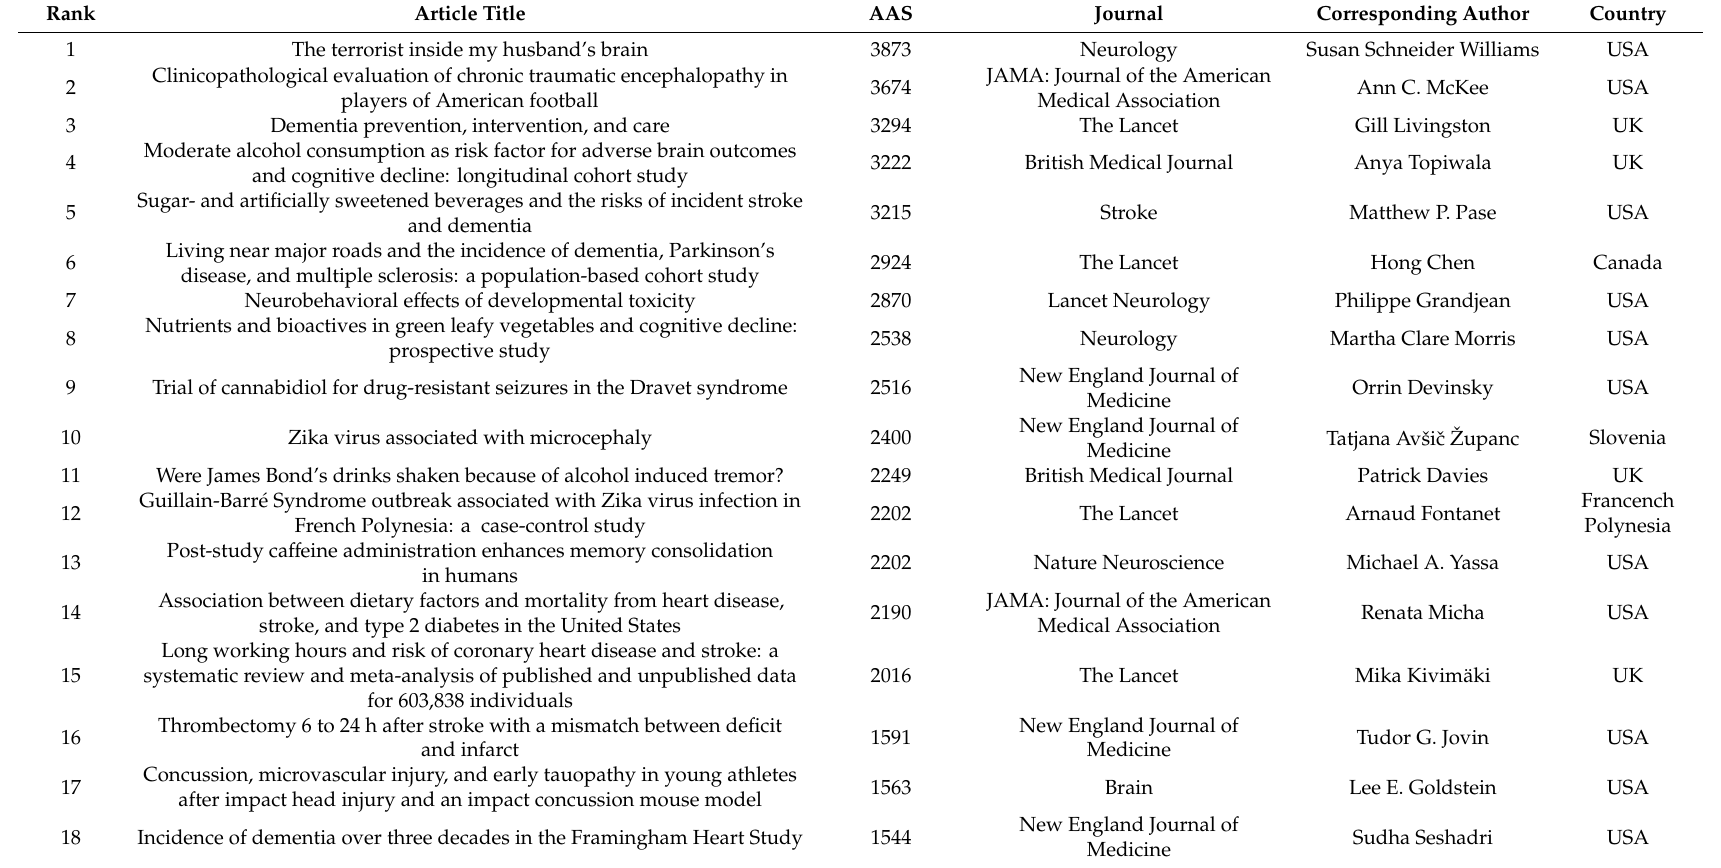
Table 1. Top 100 articles with the highest Altmetric Attention Scores